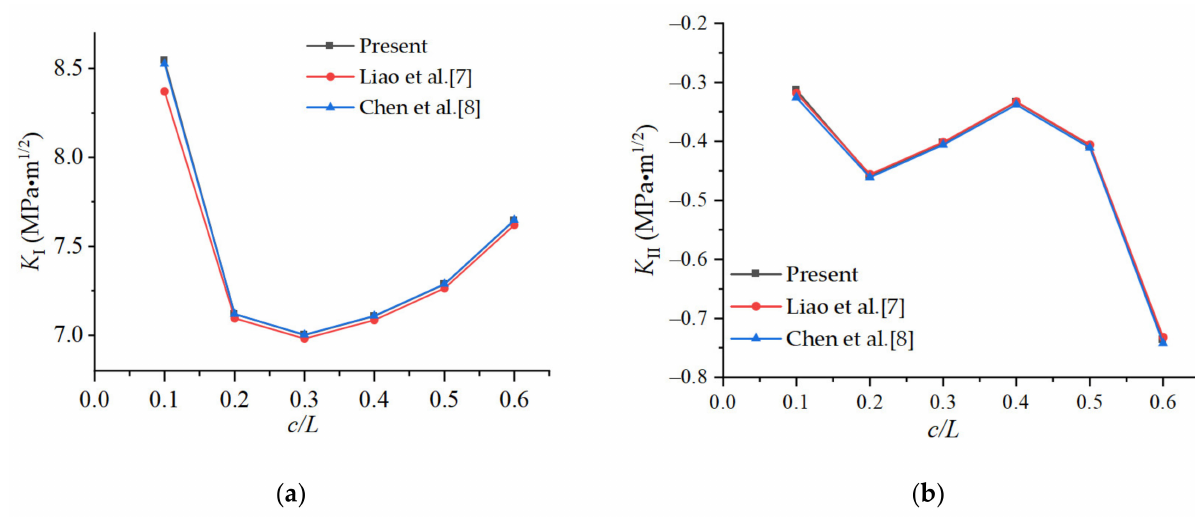
Figure 7. SIFs for different crack spacing ( L/W = 2): ( a ) SIFs K I ; ( b ) SIFs K II .